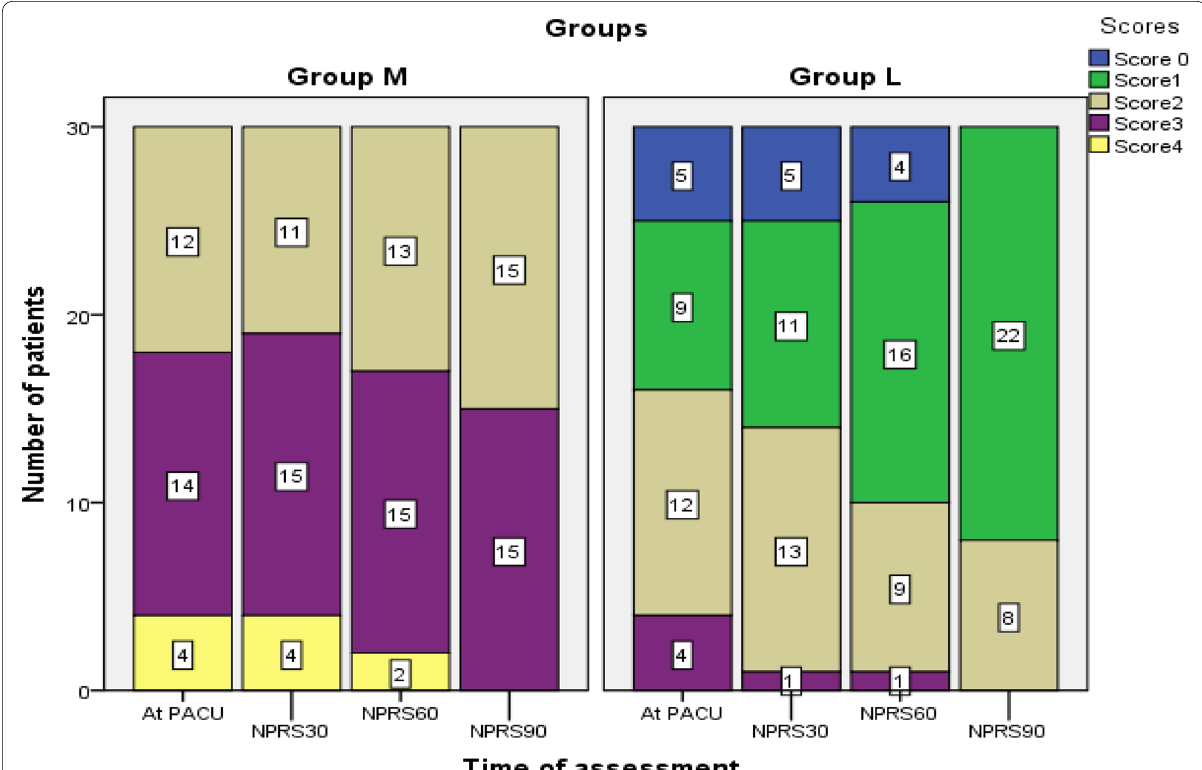
Fig. 5 Frequency distribution of the Numeric Pain Rating Score (NPRS) in the post‑anesthesia care unit